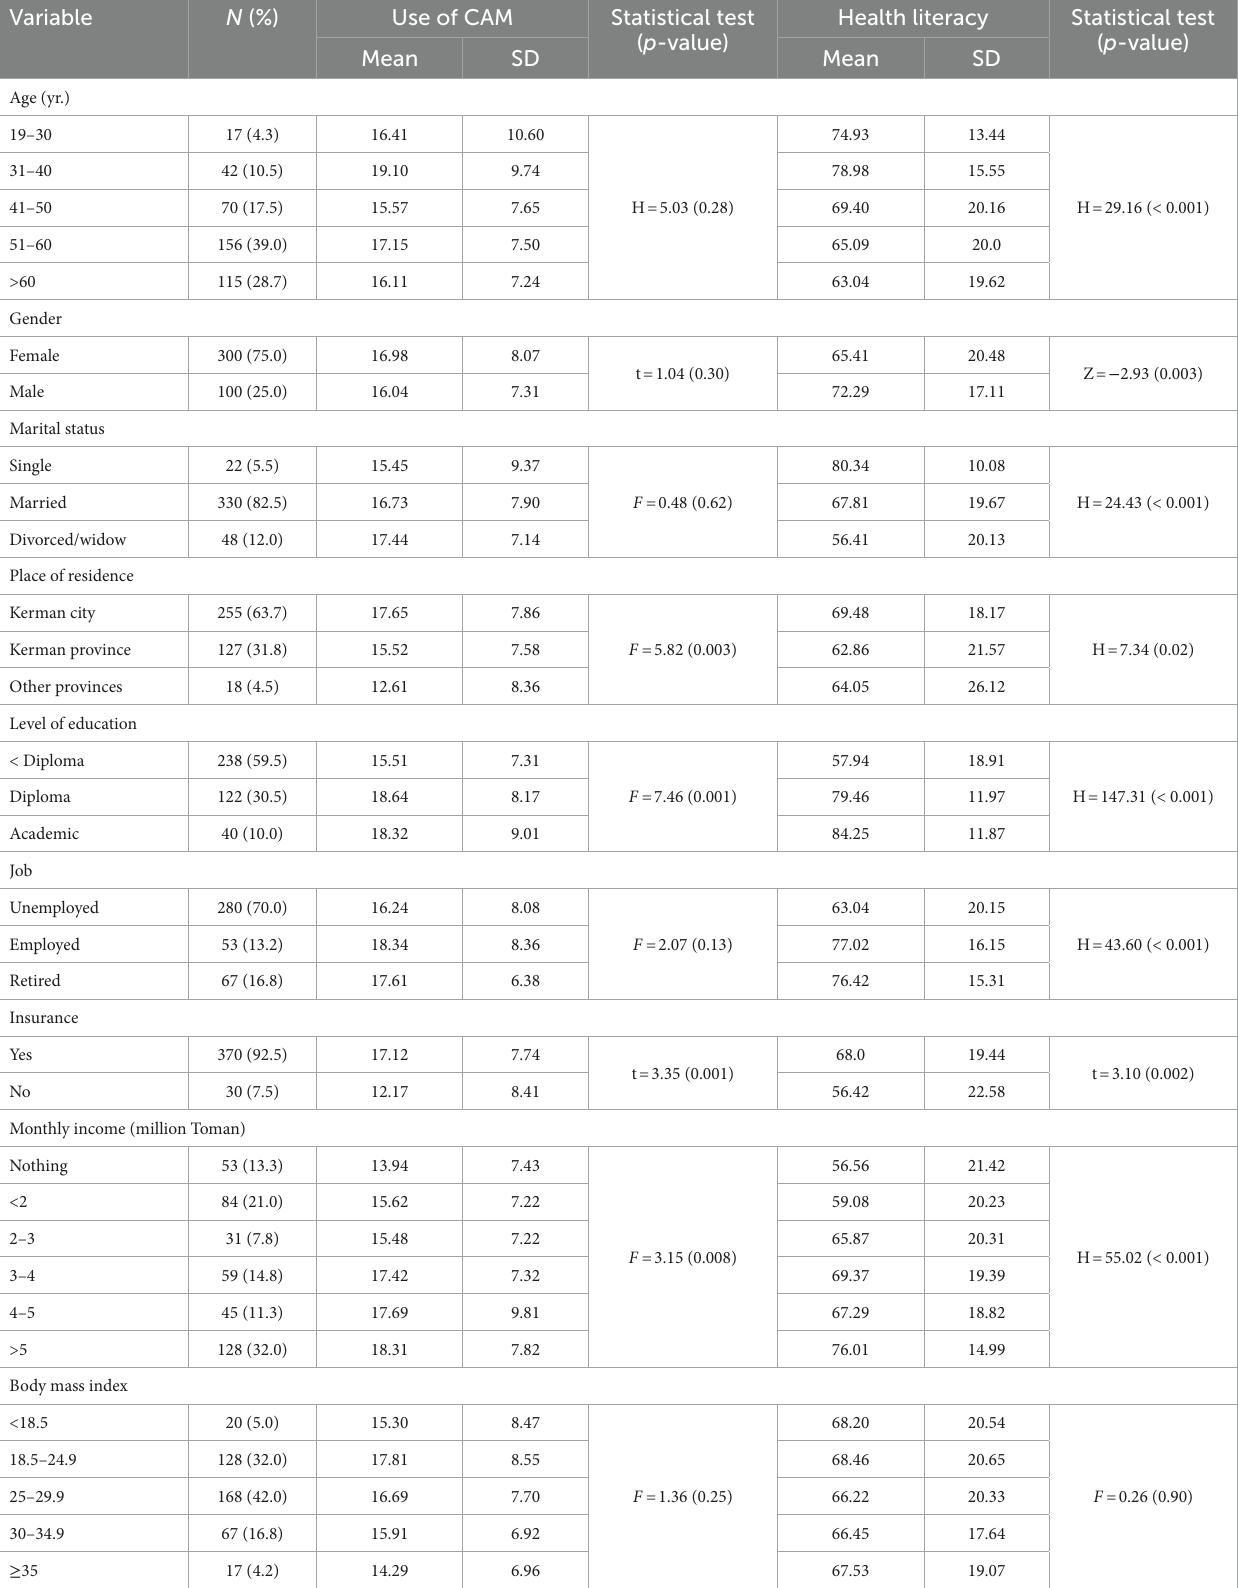
TABLE 1 Participants’ characteristics and their relations with the use of complementary and alternative medicine and health literacy. Variable N (%) Use of CAM Statistical test Health literacy Statistical test ( p -value) ( p -value) Mean SD Mean